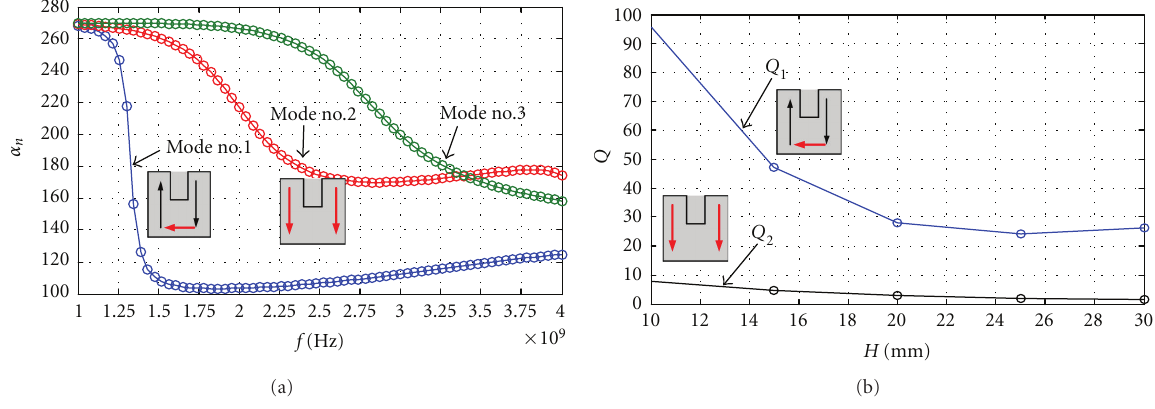
Figure 12: Characteristic angles (left) and radiation Q for the SAU2.